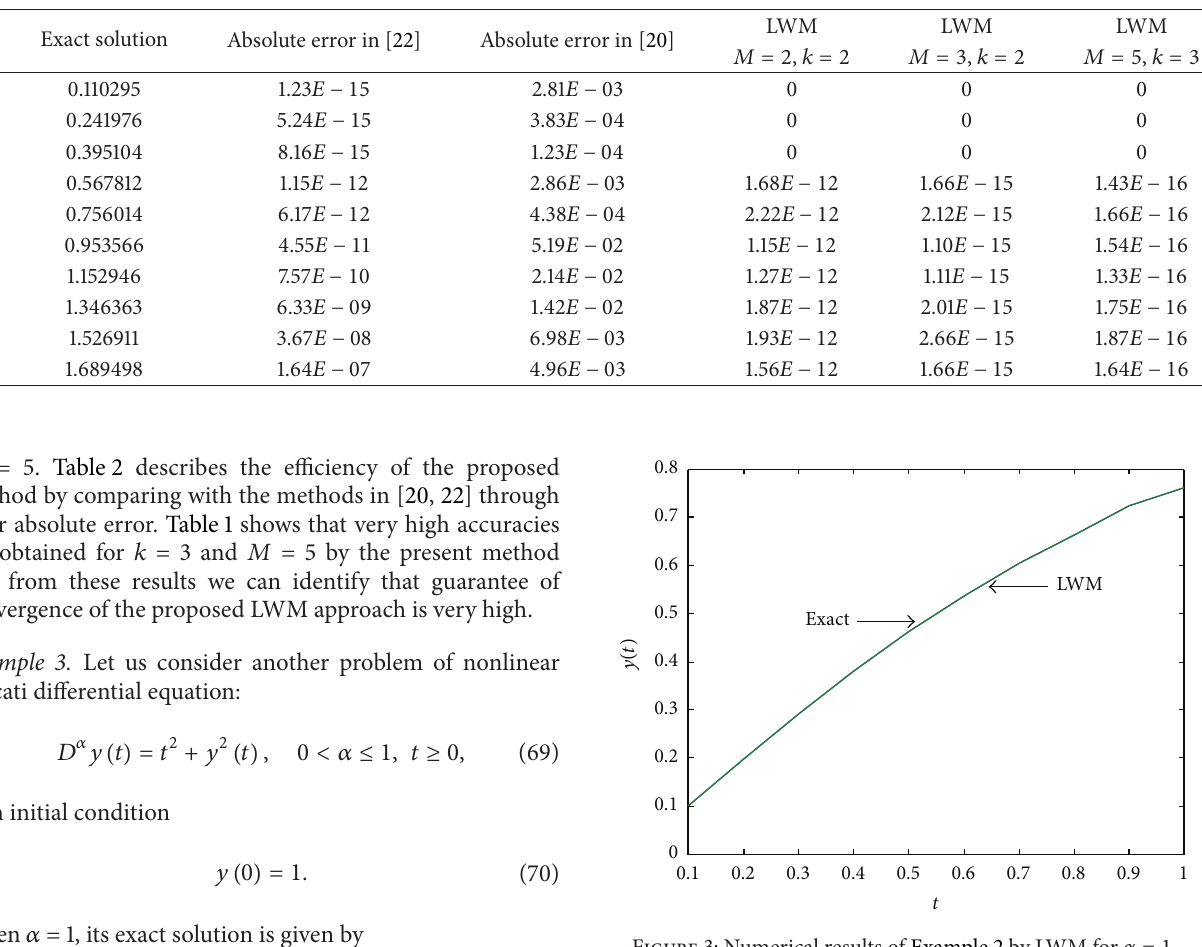
Table 2: Numerical results of Example 2 for 𝛼 = 1 .